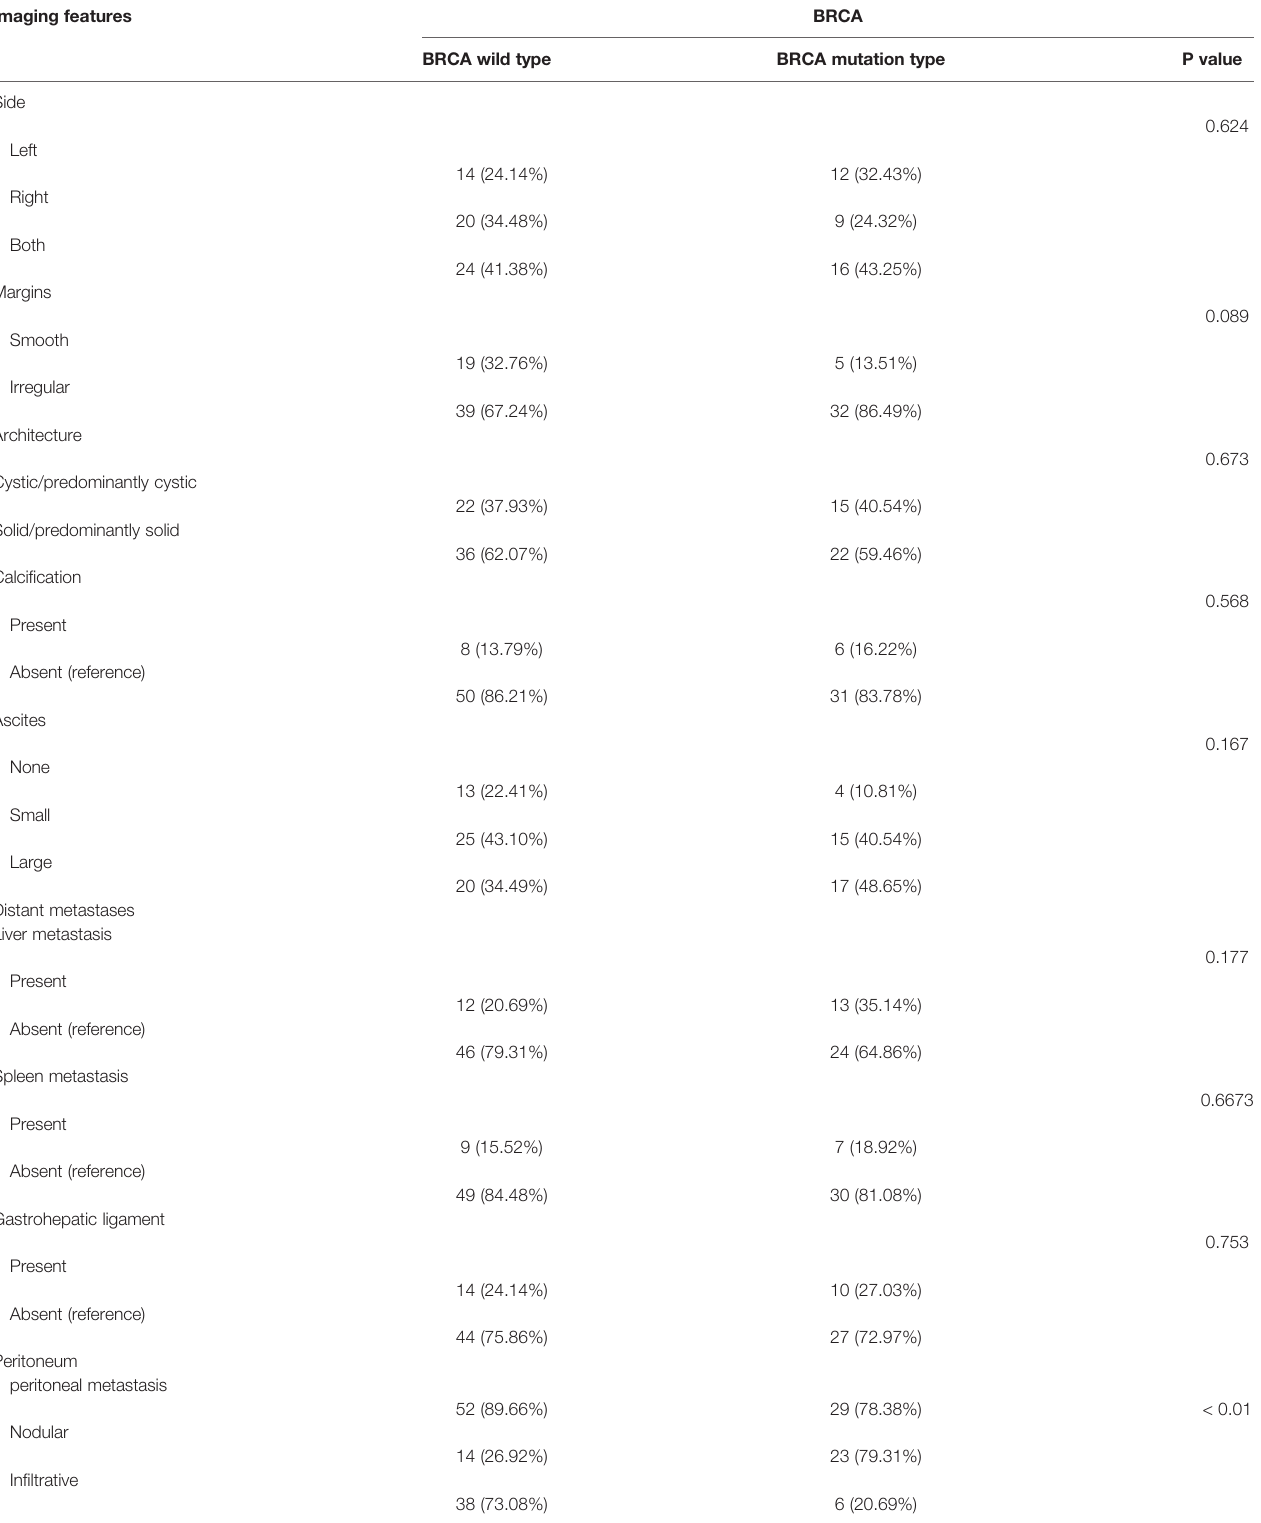
TABLE 2 | Mann-Whitney U test results of correlation between imaging features and BRCA mutation